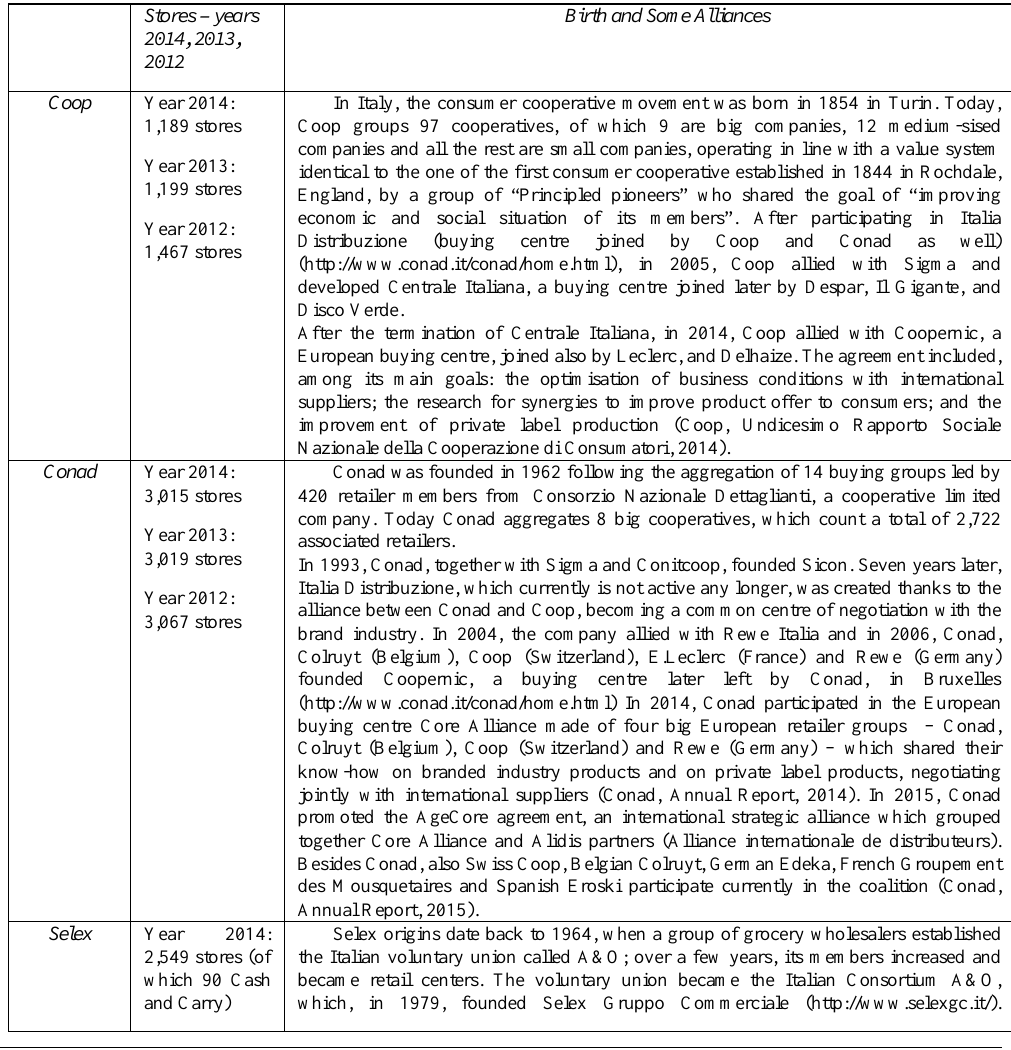
Table 4: Stores and Some Alliances 2 of the three Largest Italian Retailers Ranked by